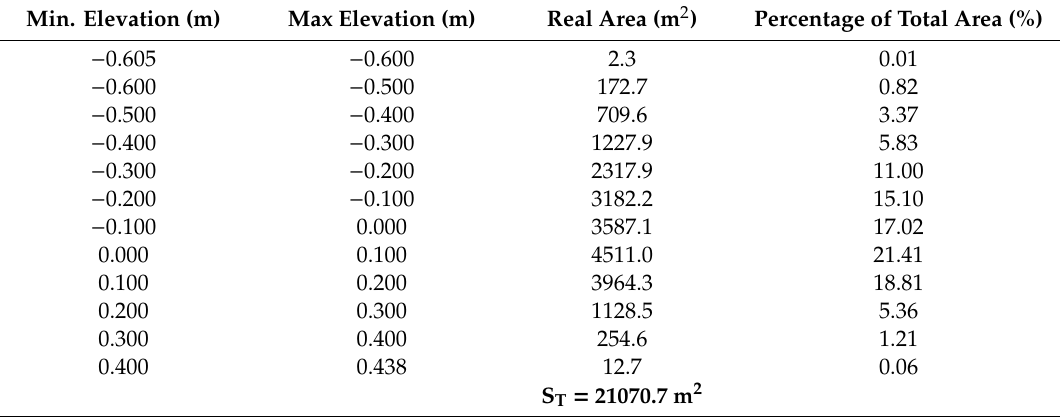
Table 2. Division of the waterbody adjacent to the municipal beach in Gdynia with respect to height differences between 2016 and 2018 Digital Terrain Models ( DTM).